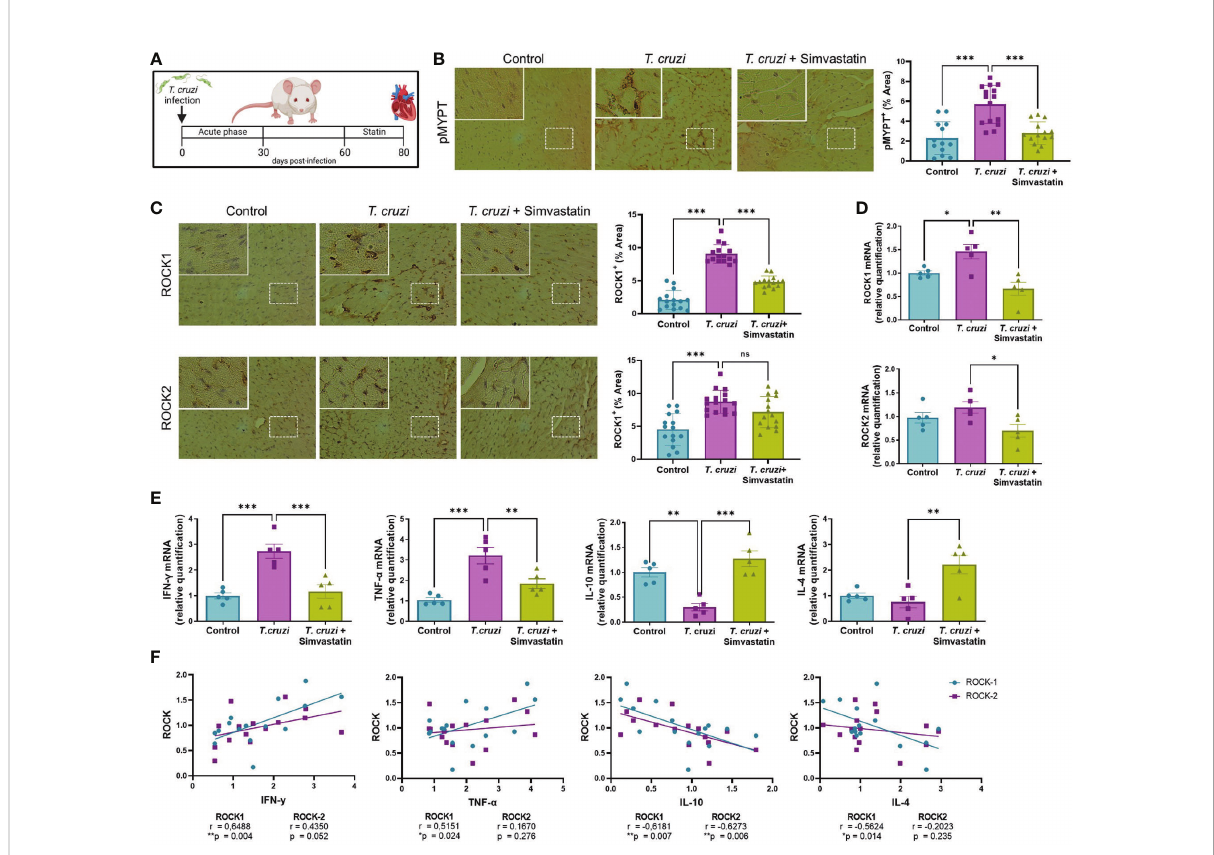
FIGURE 5 Simvastatin reduces ROCK activation and pro-in fl ammatory cytokine expression in cardiac tissue of an in vivo model of chronic Chagas cardiomyopathy. BALB/c mice were infected with 1 x 10 3 trypomastigotes of the Dm28 strain. At day 60 post-infection, mice were treated with 1 mg/Kg simvastatin per day for 20 days (25). At day 80 post-infection, mouse hearts were collected for RT-qPCR and immunohistochemistry analysis. (A) Experimental murine model. (B) Immunohistochemistry for cardiac p-MYPT1 and relative levels. (C) immunohistochemistry for cardiac ROCK1 and ROCK2 and relative levels. (D) Relative quanti fi cation of ROCK1 and ROCK2 mRNA levels. (E) Relative quanti fi cation of cytokine mRNA levels. Data are expressed as mean ± SD of 5 mice. *p<0.05 **p<0.01 ***p<0.001 analyzed with one-way ANOVA and Dunnett post-test. (F) Linear correlation between ROCK and cytokine mRNA levels. *p<0.05, **p<0.01, analyzed with Pearson correlation coef fi cient